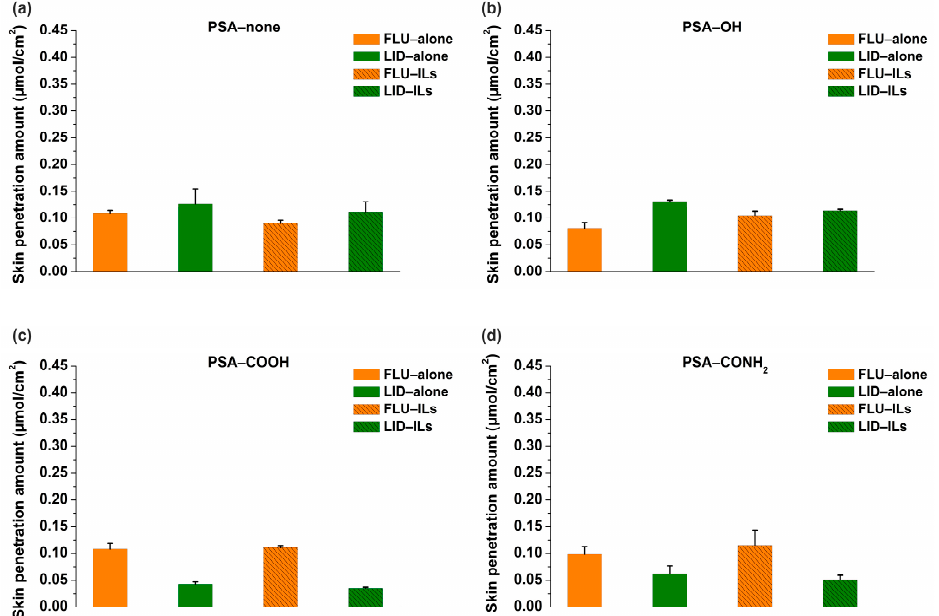
Figure 6. The in vitro skin permeation results of FLU, LID and ILs in the PSA − none ( a ), PSA − OH ( b ), PSA − COOH ( c ), and PSA − CONH 2 ( d ) ( n = 4).